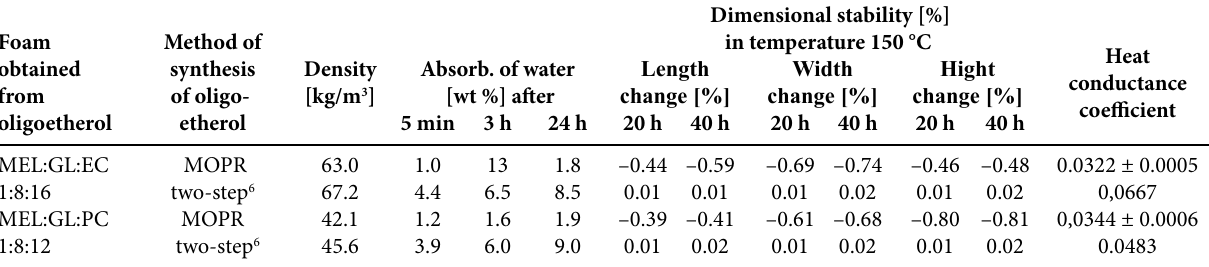
Dimensional stability [%]